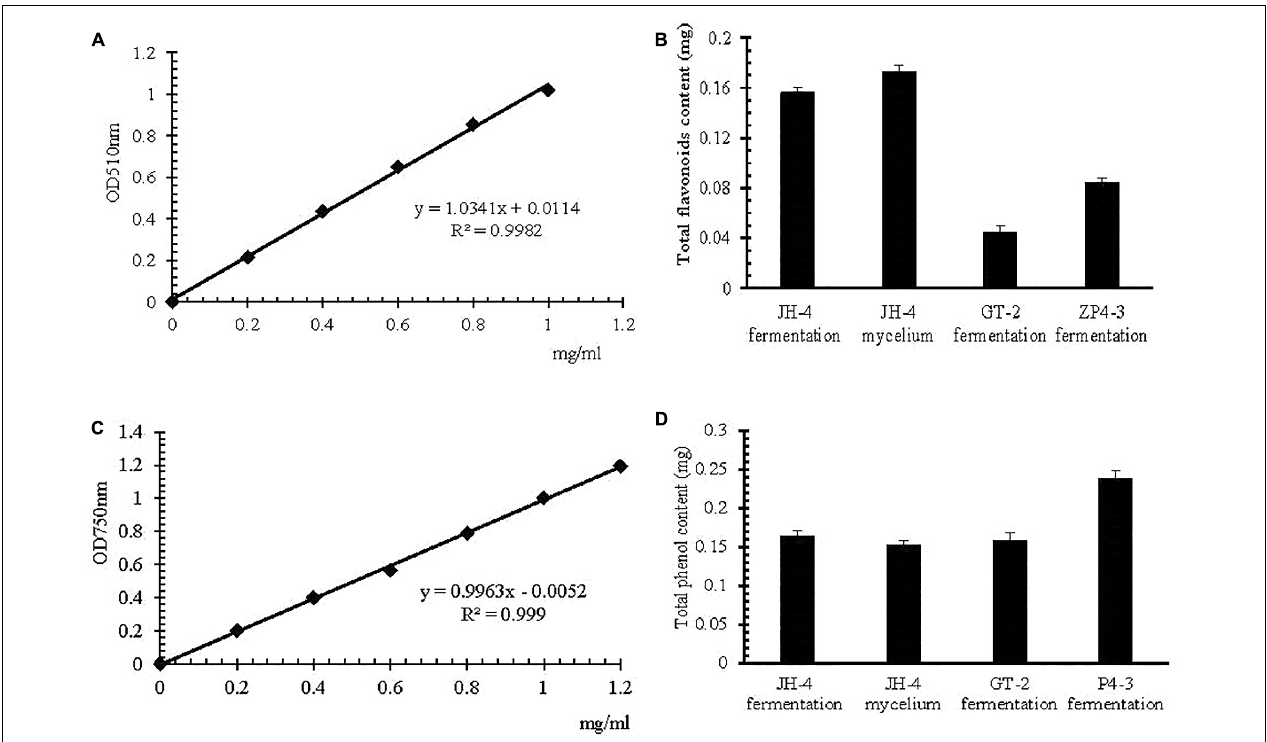
FIGURE 4 | Estimation of total flavonoid and total phenol content. (A) Rutin standard curve. (B) Total flavonoid content. (C) Gallic acid standard curve. (D) Total phenol content.